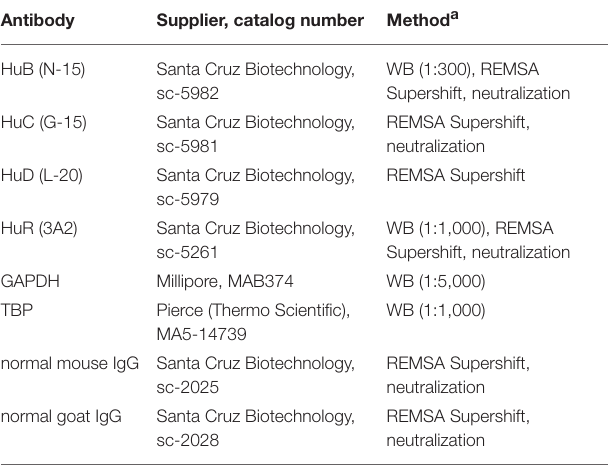
TABLE 2 | Antibodies for WB, neutralization, and REMSA